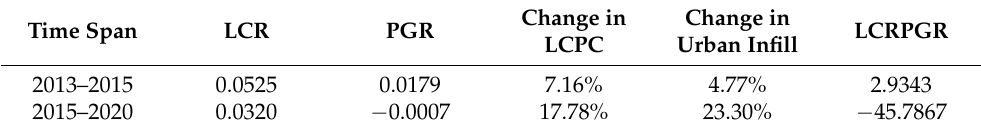
Table 4. SDG11.3.1 indicators from 2013 to 2015 in Guilin.